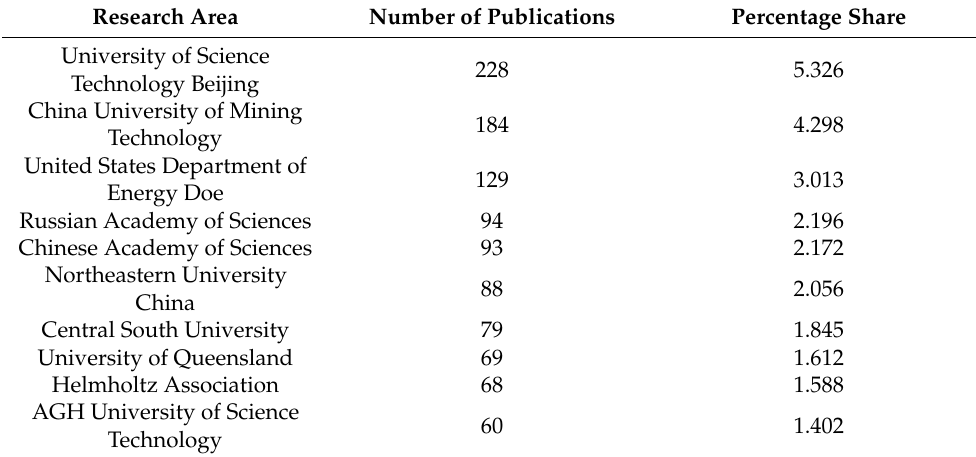
Table 4. Top 10 publishing